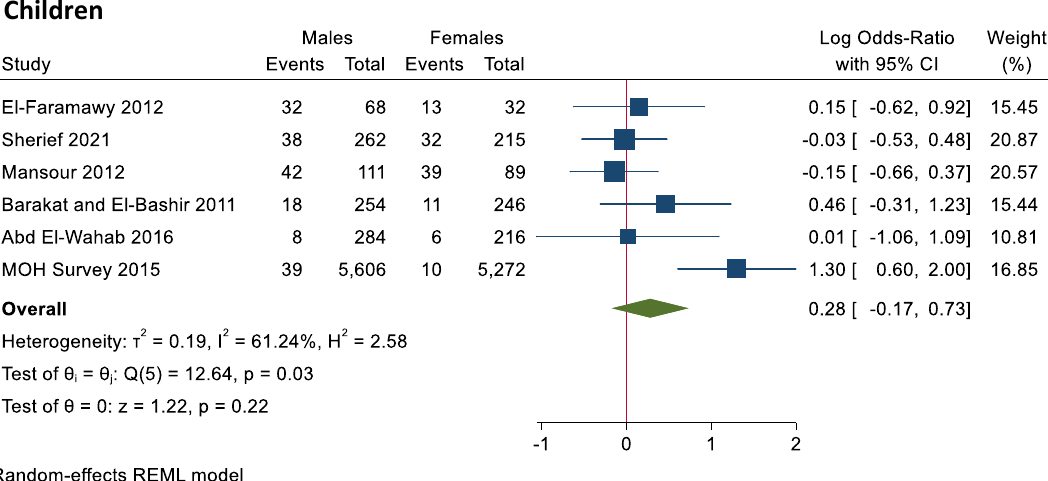
Figure 3. Forest plot of prevalence of HCV RNA in males and females. There is statistically significant increase in prevalence of HCV RNA positivity in males than females. Children